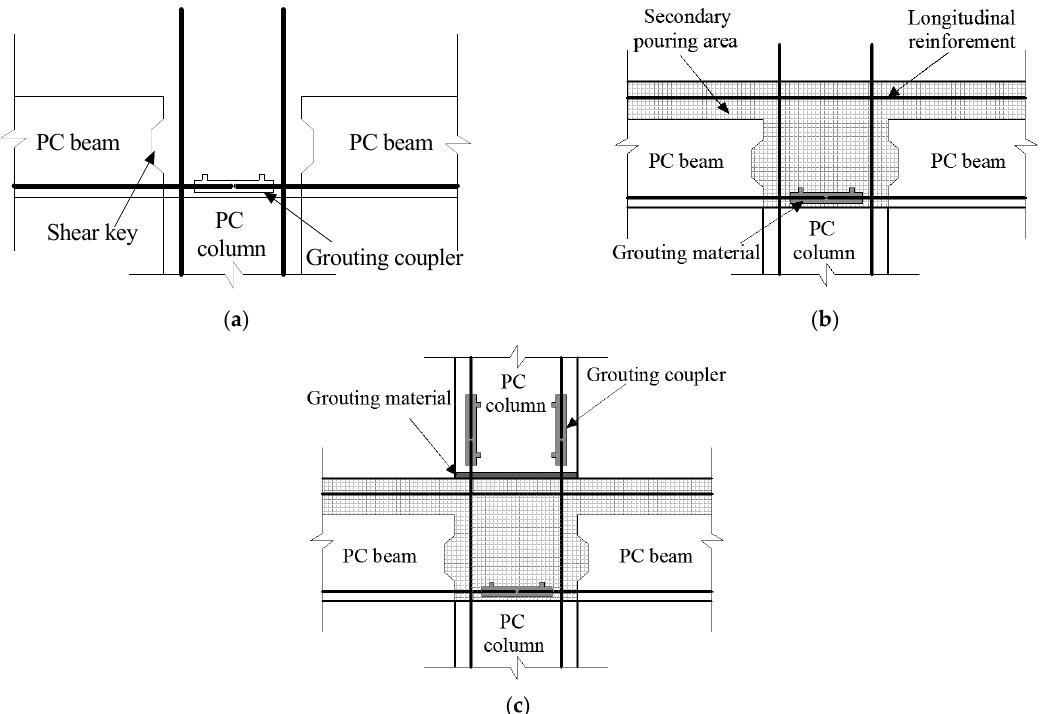
Figure 5. Assembly process for PC connection: ( a ) locations of beam and column; ( b ) secondary pouring; ( c ) grouting curing.